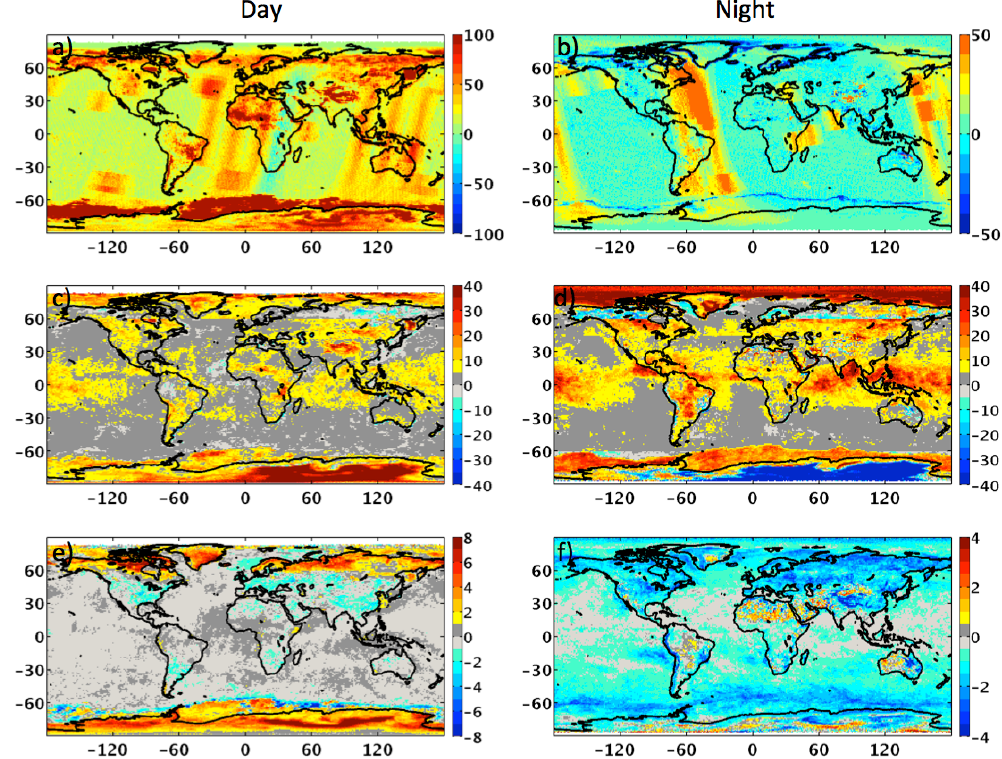
Figure 19. Daytime (right panels) and nighttime (left panels) sample number changes (a, b) , cloud fraction changes (%, c and d ), and cloud optical depth changes (e, f) between Ed2SSF and Ed4SSF for each 1 ◦ latitude × 1 ◦ longitude region, using Terra measurements of October 2002.